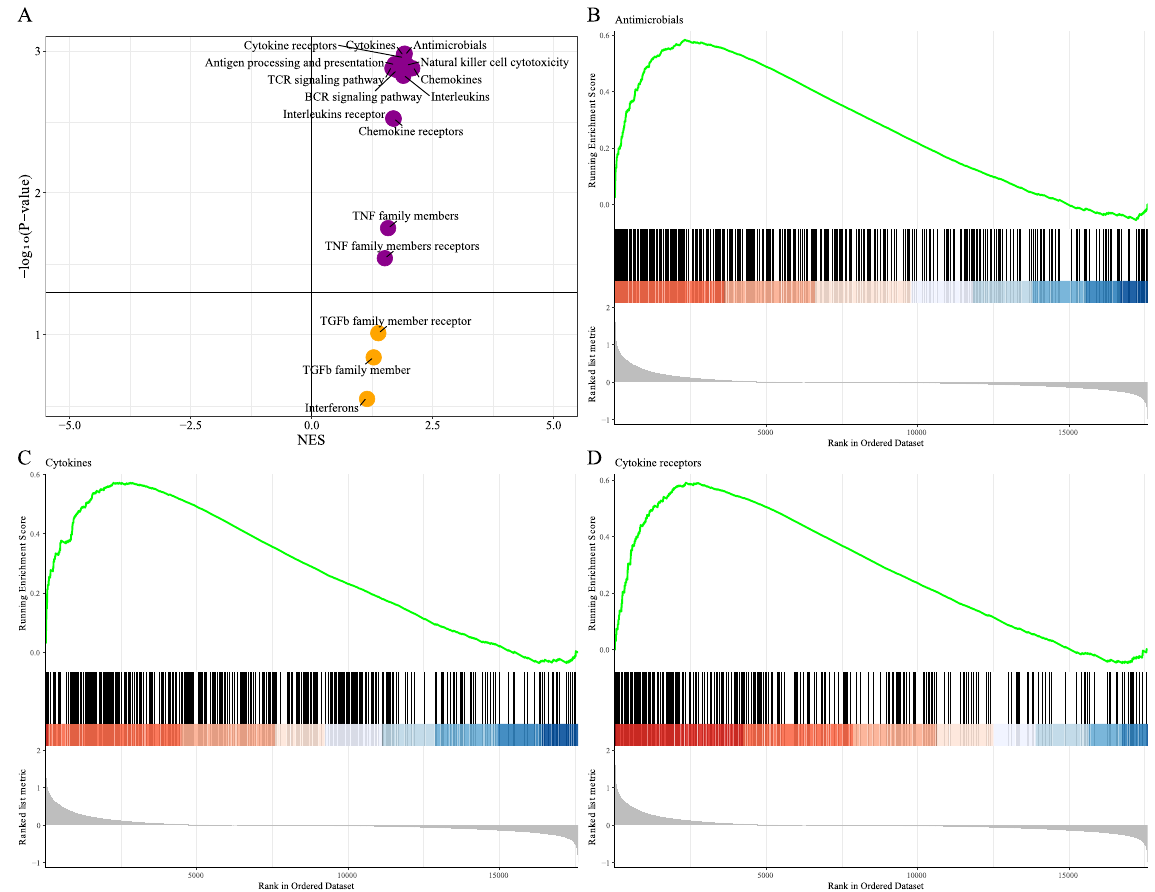
Figure 4. The GSEA delineated the enriched immune cell types. ( A ) Volcano plot of GSEA for the cluster 1 when compared with the cluster 2. GSEA of (B) antimicrobials, (C) cytokines and (D) cytokine receptors for the cluster 1 when compared with the cluster